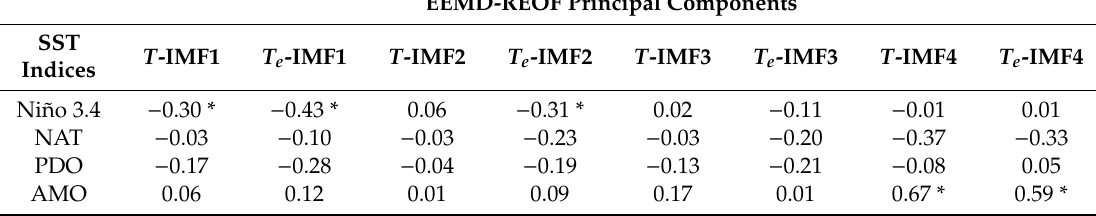
Table 1. Correlation coe ffi cients between summer SST indices and principal components of the first REOF mode of each